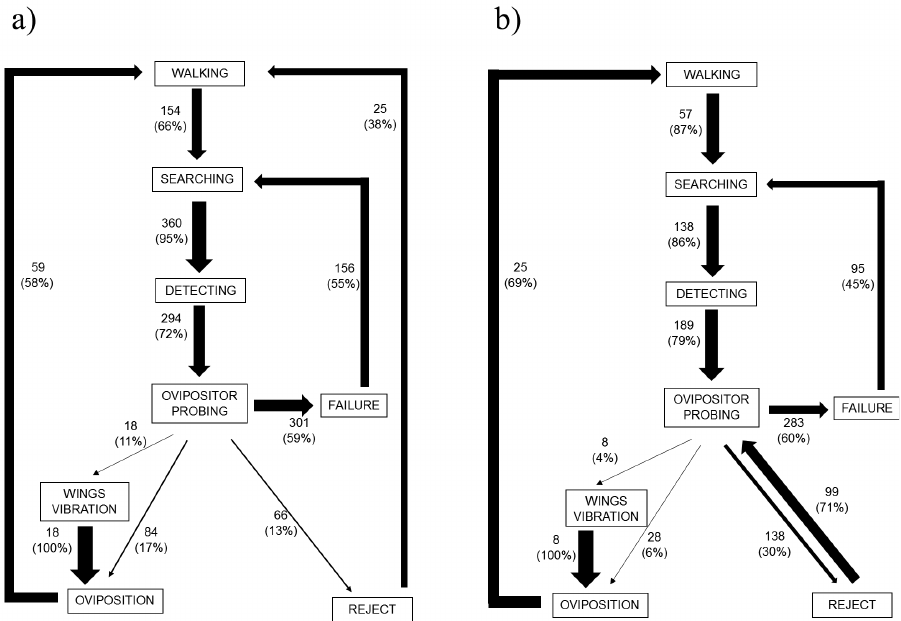
Figure 2. Ethogram of oviposition of females of Utetes anastrephae on non-parasitized larvae ( a ) and larvae previously parasitized by conspecifics ( b ) under laboratory conditions. The width of the arrow is proportional to the relative frequency of transition. The numbers associated with the arrows represent the observed frequencies of the successive behaviors of a complex sequence of behavior (proportions are indicated in